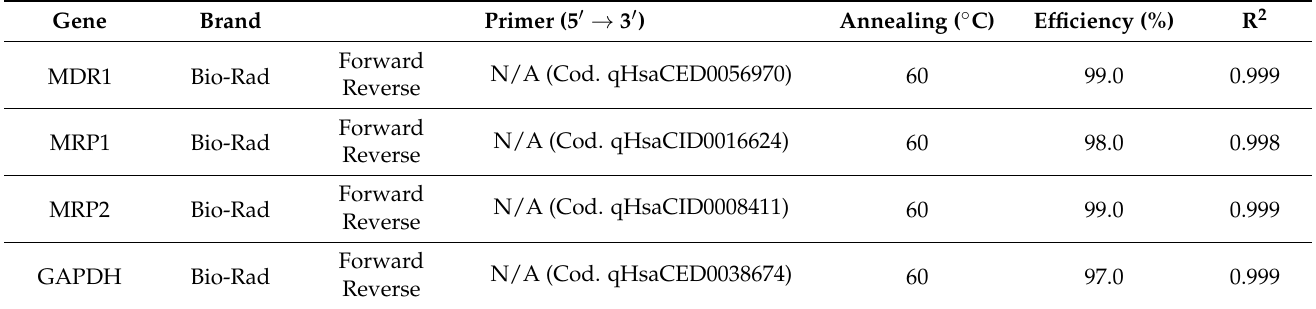
Table 1. List of primers, general conditions, and validation parameters used to perform